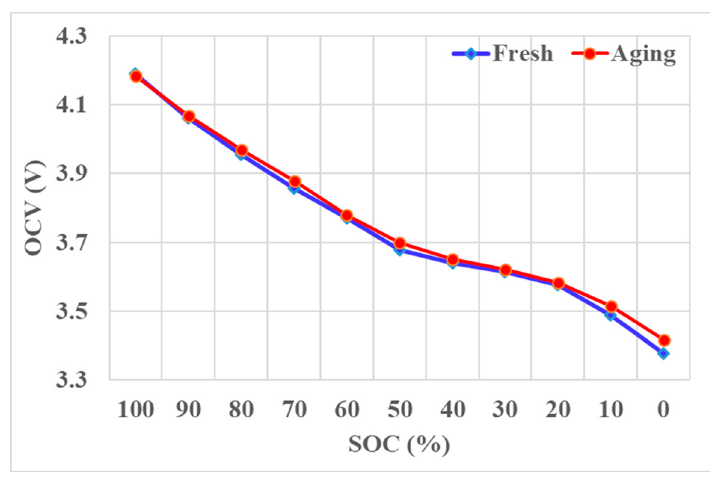
Figure 6. Comparison of the SOC-OCV curve between the fresh and aging condition.